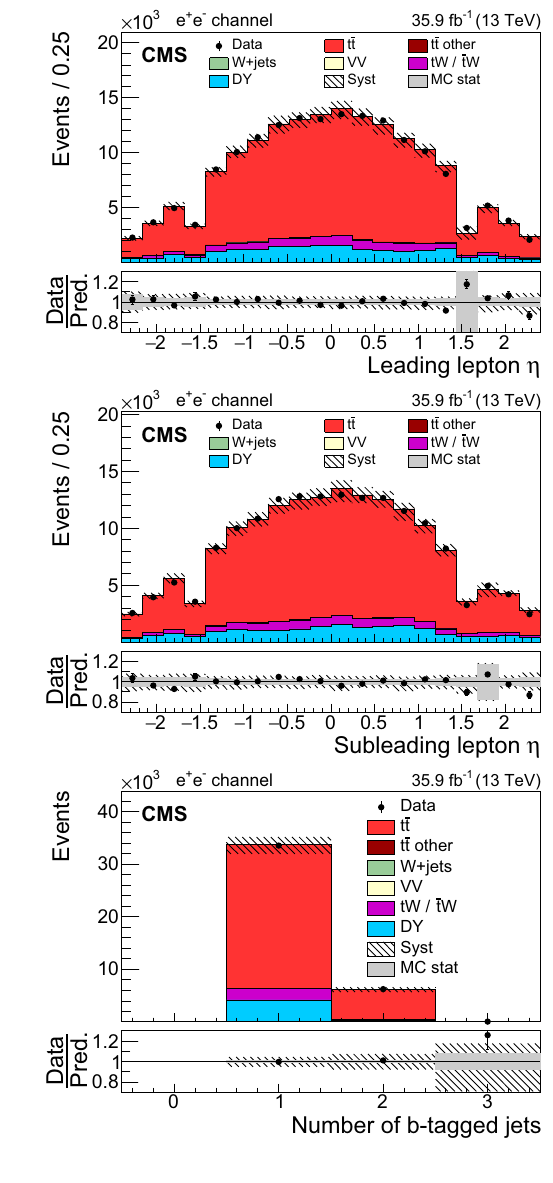
Fig. 3 The same distributions as in Fig. 1, but for the e + e − channel The template dependencies are rederived and the fit to